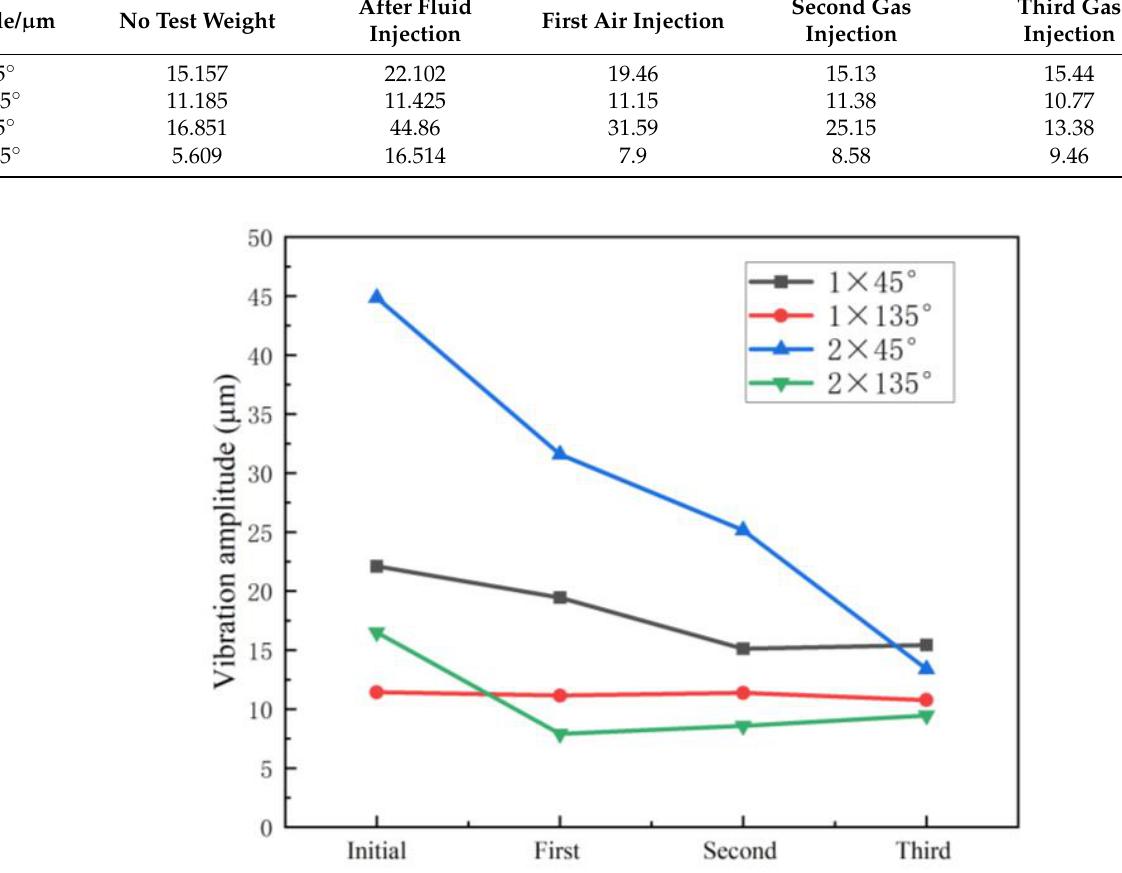
Figure 19. Amplitude of each measurement point during dynamic test.